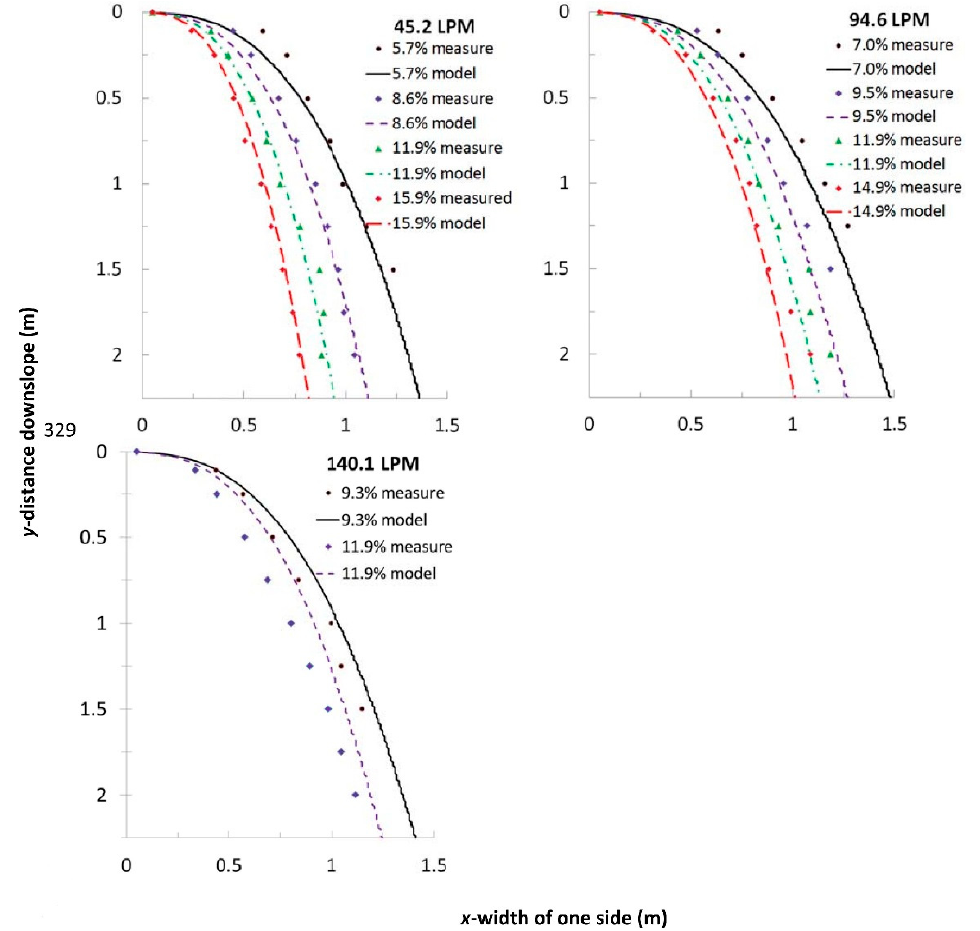
Figure 5. Measured and modeled results of one side of the water spreading onto a fine bladed artificial turf for varying Q and S y with x 0 = 10.2 cm. The measured x values are the average of the right and left sides at that value of y .